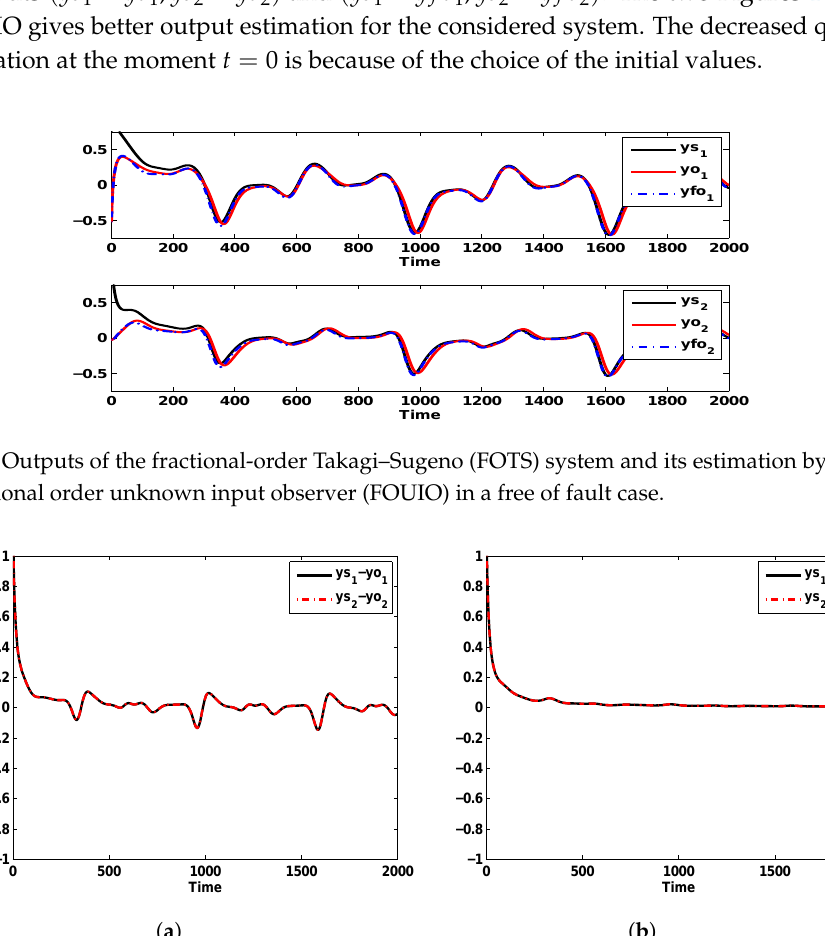
Figure 2. Output estimation Error in a free of fault case. ( a ) Error output estimation of the FOTS system by FUIO in a free of fault case. ( b ) Error output estimation of the FOTS system by FOUIO in a free of fault